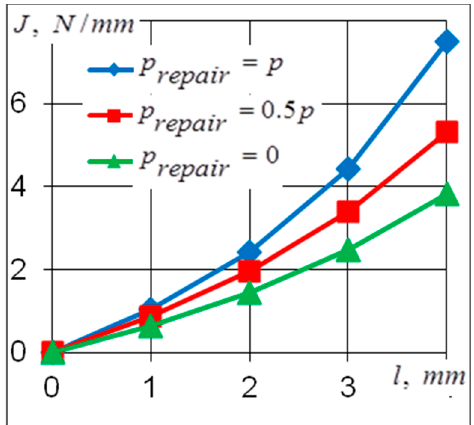
Figure 5. The dependence of the J-integral on the depth of the defect.